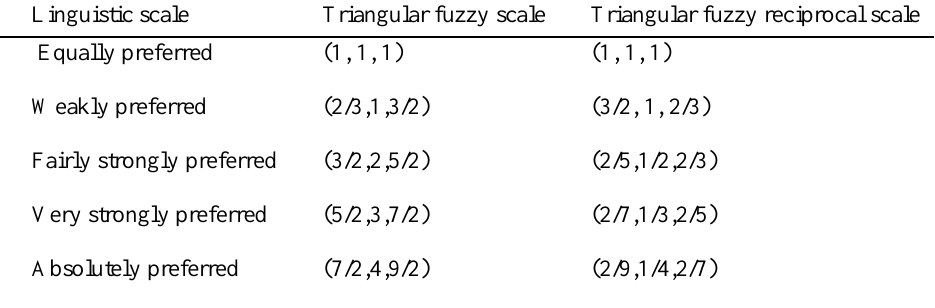
Table 3. The linguistic variables and their corresponding fuzzy numbers.